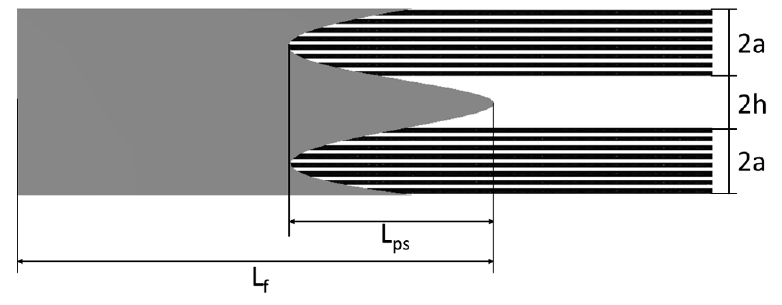
Figure 3. Length of the partially saturated flow front L ps .